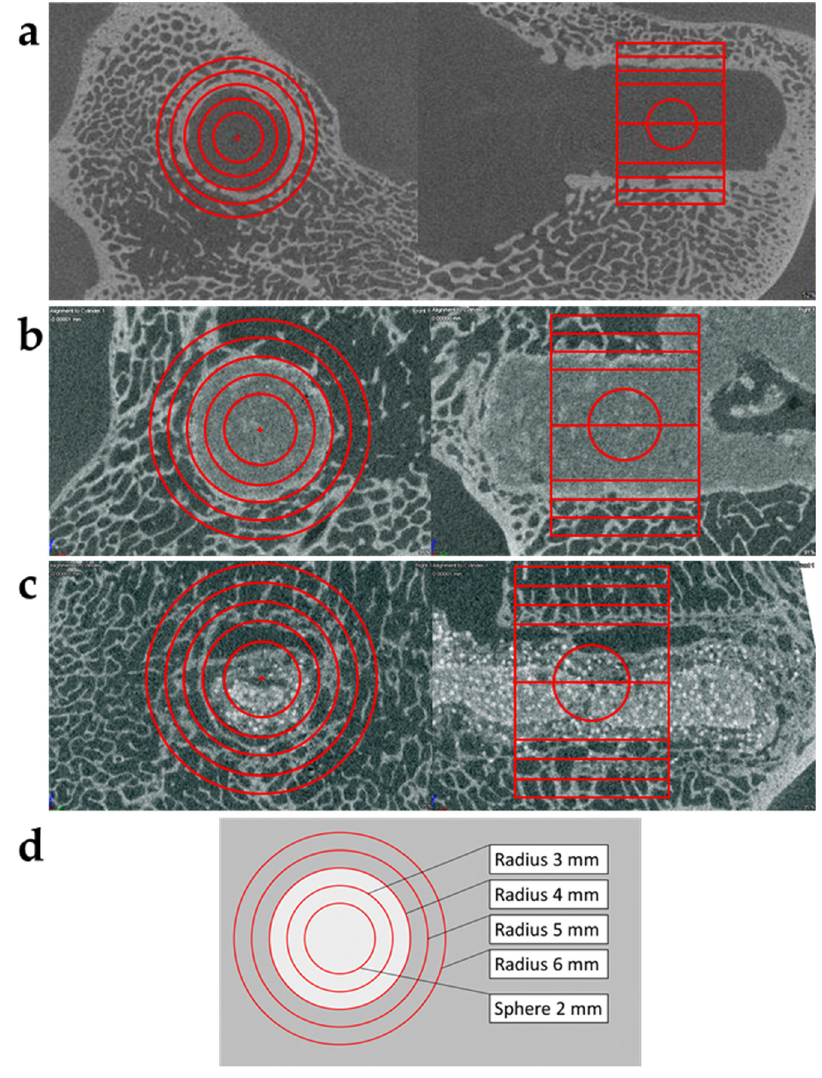
Figure 1. ( a – c ) show micro CT constructs in two different planes of samples after 3 months in vivo. ( a ) Sample derived from the left tibia (negative control, empty hole) of an animal receiving BoneReg-Inject™ in right leg drill hole, still essentially void of mineralized tissue. A rim of increased density integrated with the adjacent trabeculum on the edge surrounding the drill hole. The figure shows how virtual cylinders were created, concentric to the drill hole and with different radiuses. ( b ) BoneReg-Inject™ treated sample from the right tibia. A rim of mineralized tissue, well integrated with the adjacent trabecular bone, surrounding the implant, islands of dense material are scattered within the body of the implant. ( c ) chronOS Inject ® treated sample from the right tibia. High density granules, characteristic for chronOS Inject ® are apparent in the images. Mineralized new tissue is less pronounced in the chronOS Inject ® group compared to the BoneReg-Inject™ group. ( d ) Illustration of virtual cylinders created. Length of all cylinders was 8 mm. The largest cylinder has a radius of 6 mm, the smallest has a radius of 3 mm and in the center is a sphere with radius of 2 mm. The cylinder with radius of 4 mm (8 mm in diameter) shows the border of the drill